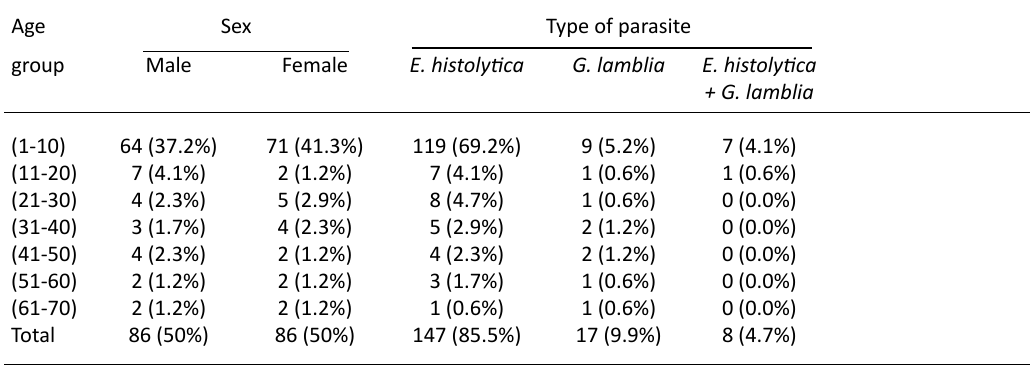
Table 4. Percentage of infection with intestinal parasites according to age groups and six factor in Nassiriyah Maternity and Children hospital and Nassiriyah general hospital.